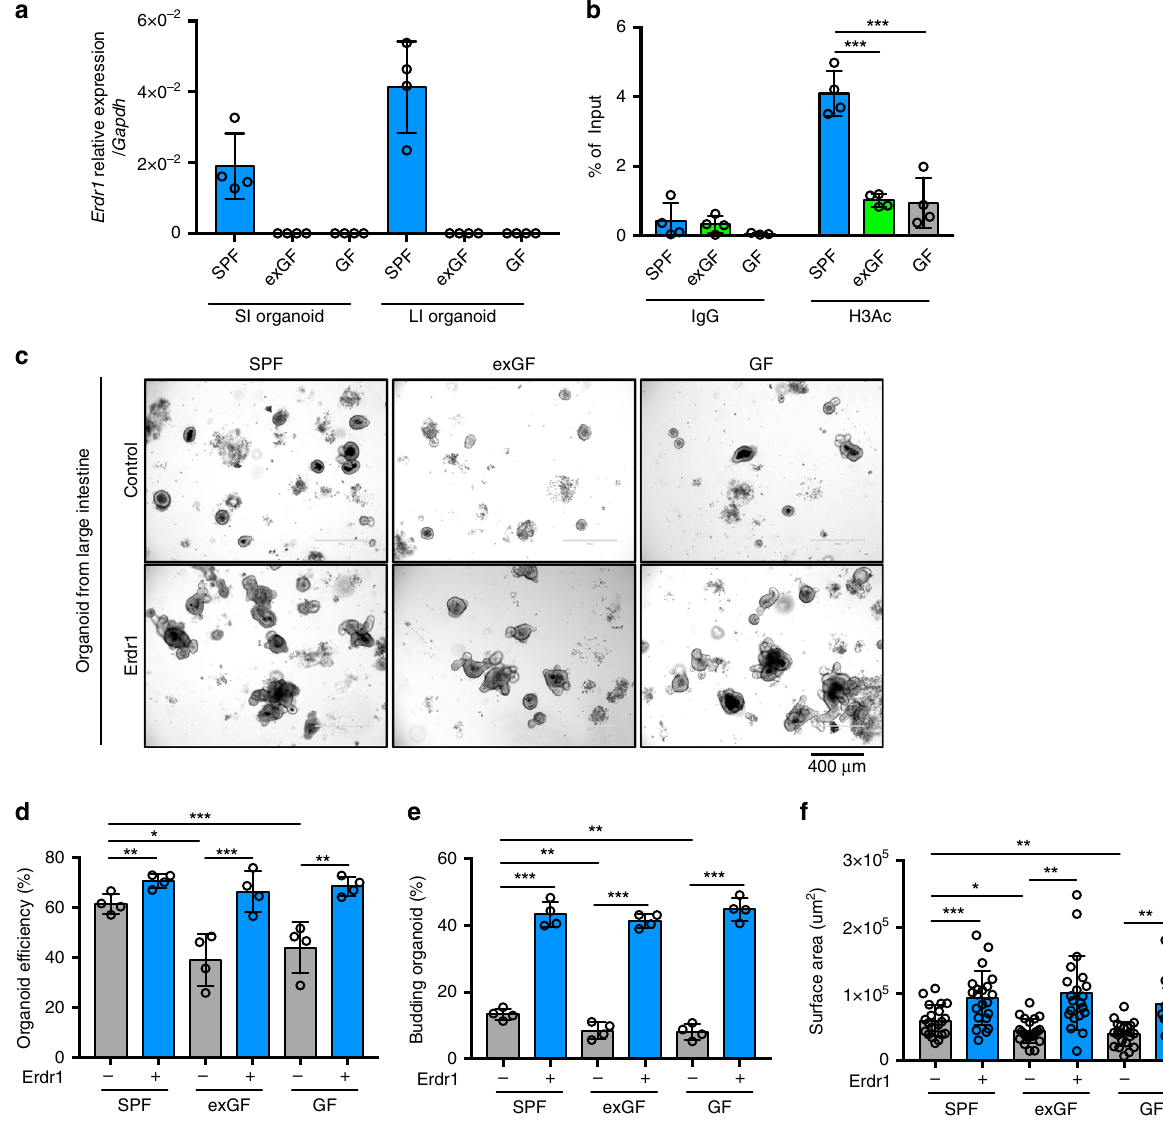
Fig. 3 Erdr1 increases growth of intestinal organoids. a Expression of Erdr1 in intestinal small and large organoids derived from SPF, exGF and GF mice. n = 4. b ChIP analysis for histone H3 acetylation (H3Ac) in the Erdr1 promoter region using large intestine (LI) organoids derived from SPF, exGF, and GF mice. n = 4; two independent experiments. c Representative images of LI organoids derived from SPF, exGF, and GF mice and cultured ±Erdr1 (1 μ g) for 6 days. d Organoid ef fi ciency of LI organoids cultured ±Erdr1. n = 4; representative of three experiments. e Frequency of budding organoids cultured ±Erdr1 for 6 days. n = 4; representative of three experiments. f Surface area of LI organoids cultured ±Erdr1. n = 21; representative of three experiments. All data are presented as mean ± SD; * P < 0.05, ** P < 0.01, *** P < 0.001 by unpaired, two-tailed t